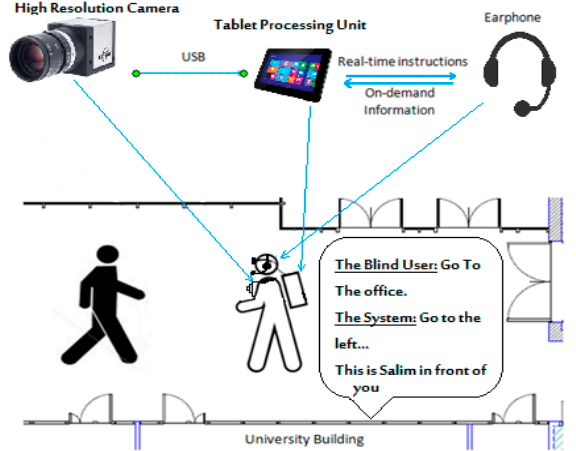
Figure 6. Overview of the BlindSys system for the visually impaired (VI). Diagram shows the camera on the chest, tablet, and headphones for voice communication.